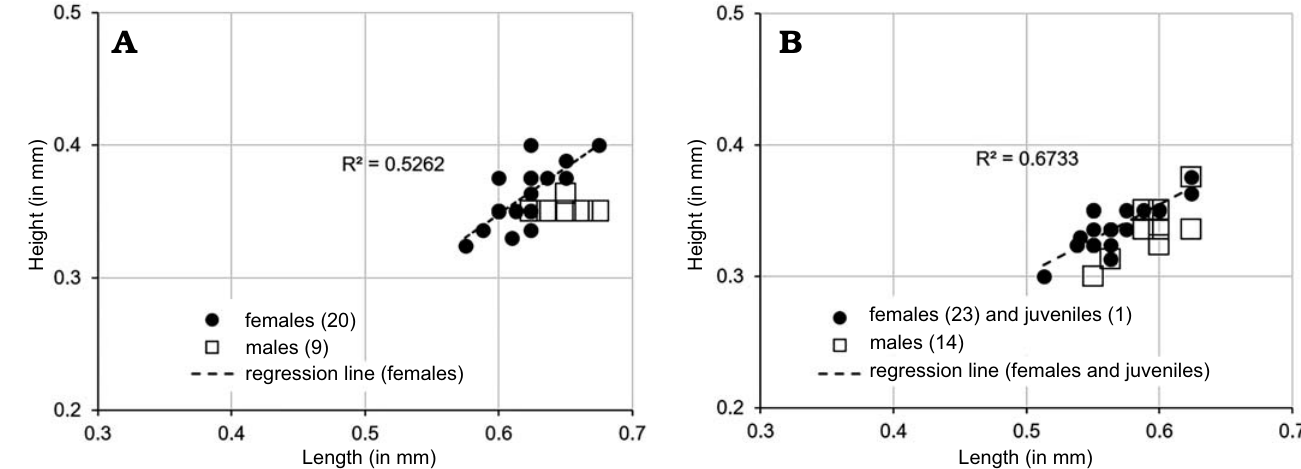
Fig. 15. Length versus height plots for Minyocythere maculosa (Bate, 1963) from UK ( A ) and Germany ( B